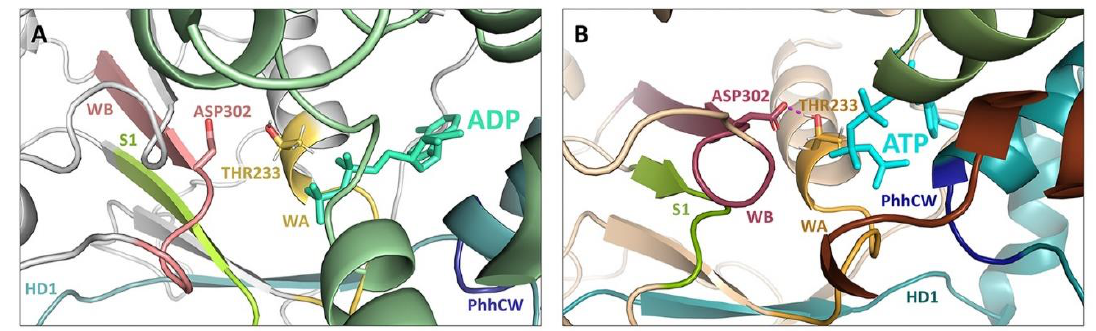
Figure 3. Molecular dynamics simulations of NLRP3 indicate key residues of the ATP-hydrolysing Walker B motif interact with ATP but not ADP. A critical hydrogen bond between the NLRP3 Walker A (WA) and Walker B (WB) positions the two motifs suitably for hydrolysis of the bound ATP (Thr233 and Asp302, respectively). In ( A ) the 3.8 Å cryo-EM structure of NLRP3 (PDB: 6NPY) is ADP-bound, and the residues are at a distance of 4.8 Å, exceeding the limit for hydrogen bond activity. However, as shown by a representative snapshot in ( B ) a 10 ns molecular dynamics simulation of NLRP3 with ATP yielded an average distance of 1.75 Å between the side chain Thr hydroxyl group in WA and Asp carboxyl group in WB, consistent with the formation of a hydrogen bond.